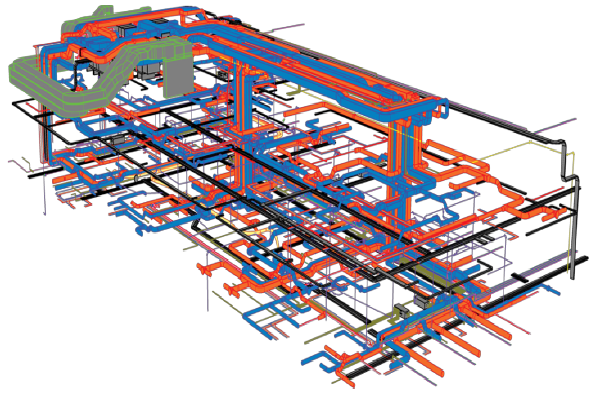
Figure 7. Pipelines as represented in the BIM model.